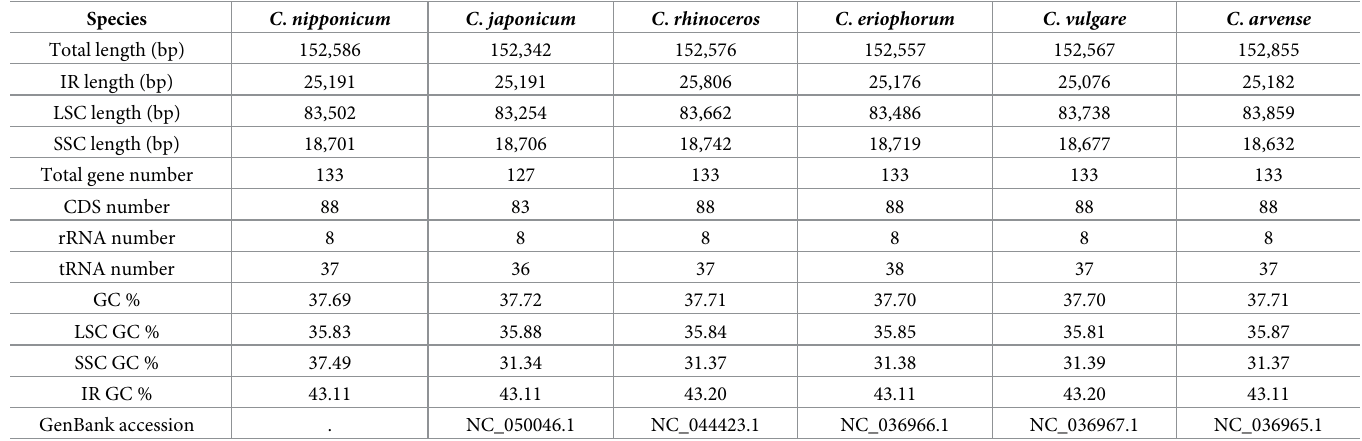
Table 2. Basic features of six Cirsium chloroplast